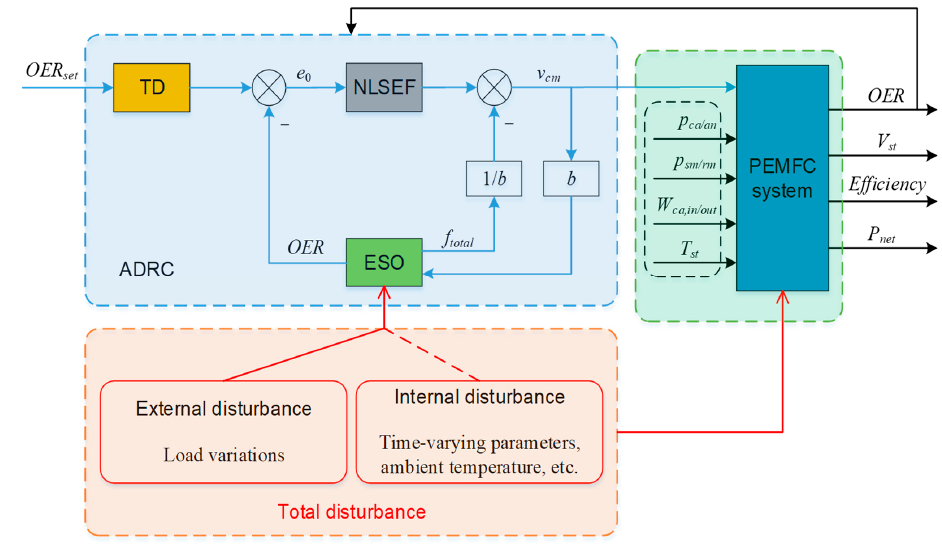
Figure 5. ADRC OER control structure of PEMFC.